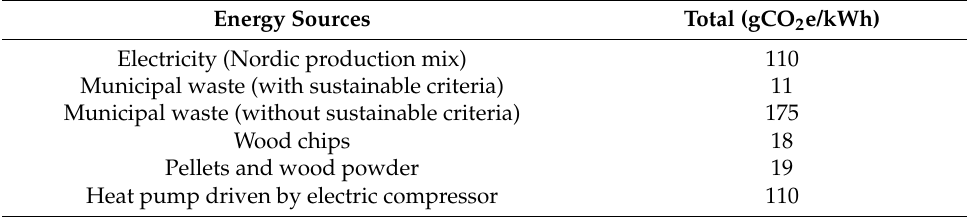
Table 7. Recommended CO 2 emission factors